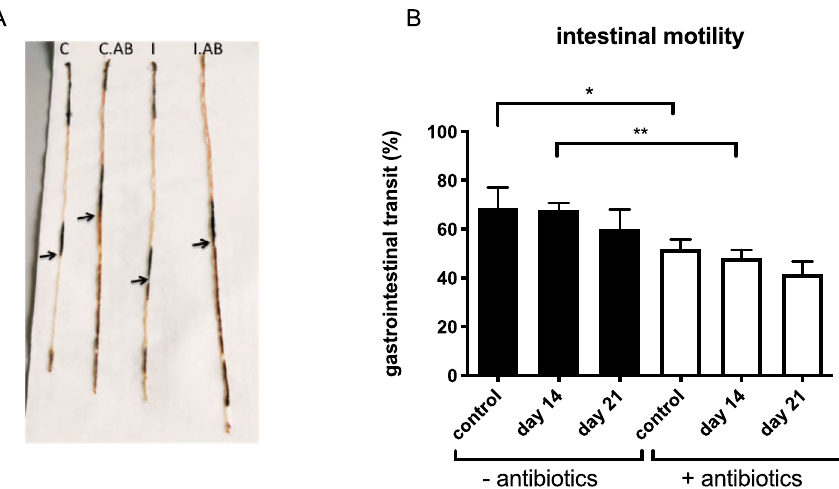
Figure 6. Effect of antibiotic treatment and G. muris infection on the intestinal motility. ( A ) Picture of murine small intestine, 20 min after oral administration of 10% charcoal solution. ( B ) Kinetics of intestinal transit following a G. muris infection in C75 BL/6 mice without (black bar) and with (white bar) antibiotic treatment. Results are shown as the mean from 5 mice with SEM as error bars. (*p ≤ 0.05, **p ≤